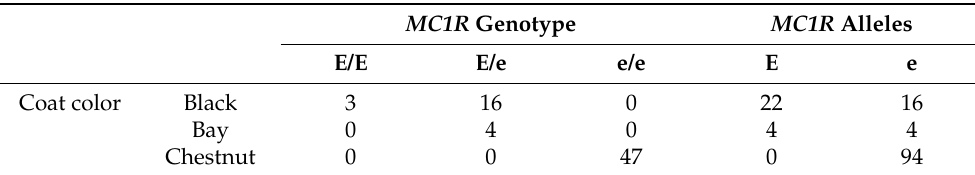
Table 1. Genotypes and alleles distribution of the MC1R polymorphism in the coat color phenotypes of the 70 genotyped Sarcidano Horse.